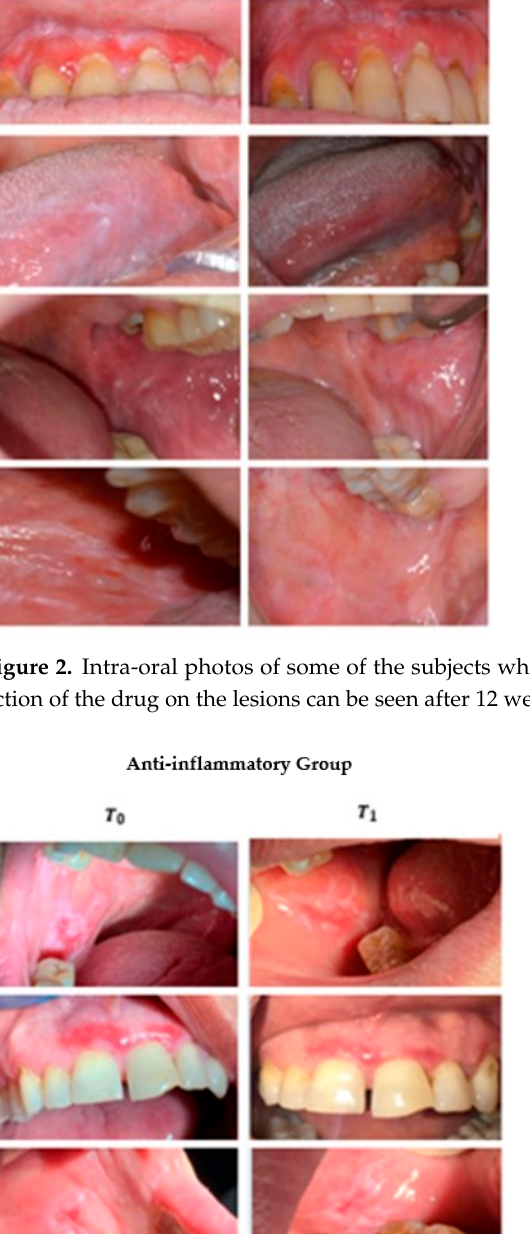
Only three patients (15%) found no remission of symptoms.